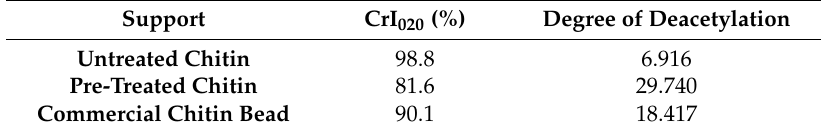
Table 5. Crystallinity index (CrI) and degree of deacetylation of different chitin supports. Support CrI 020